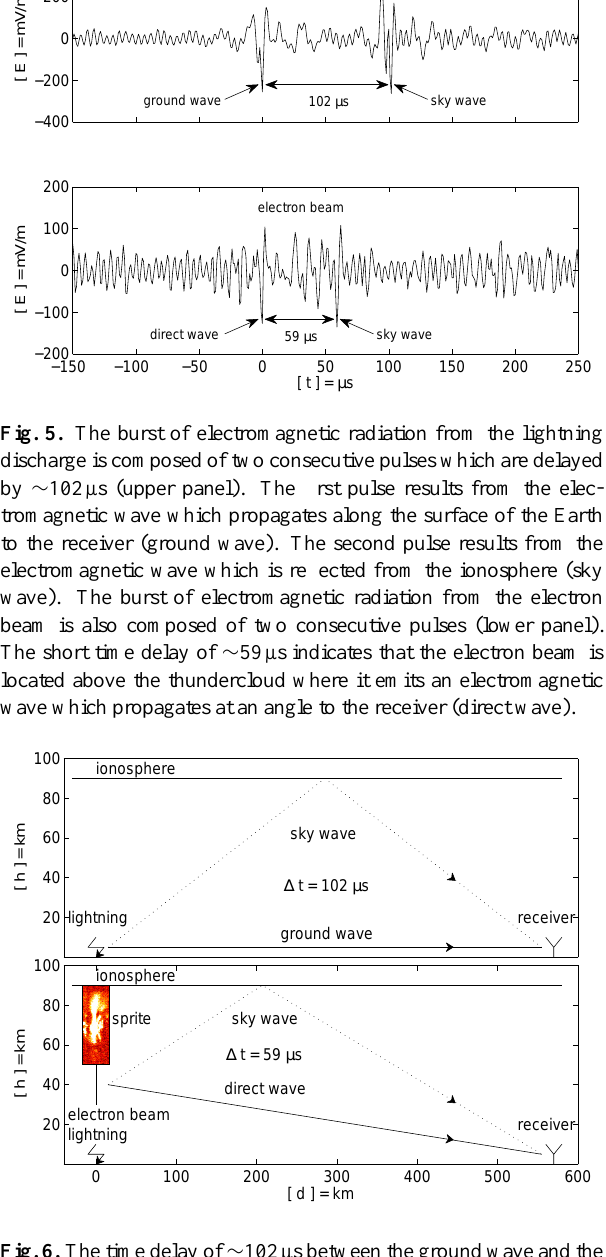
Fig. 6. The time delay of ∼ 102µs between the ground wave and the sky wave from the lightning discharge indicates that the reflecting ionosphere is located at a height of ∼ 90km (upper panel). The time delay of ∼ 59µs between the direct wave and the sky wave from the electron beam indicates that the electron beam is located at a height of ∼ 41km (lower panel). The electron beam does not emit enough photons at visible wavelengths to exceed the sensitivity limit of the charge coupled device chip of the video camera. It is concluded that electron beams above thunderclouds can coincide with sprites but that they independently discharge lightning electric fields above thunderclouds.